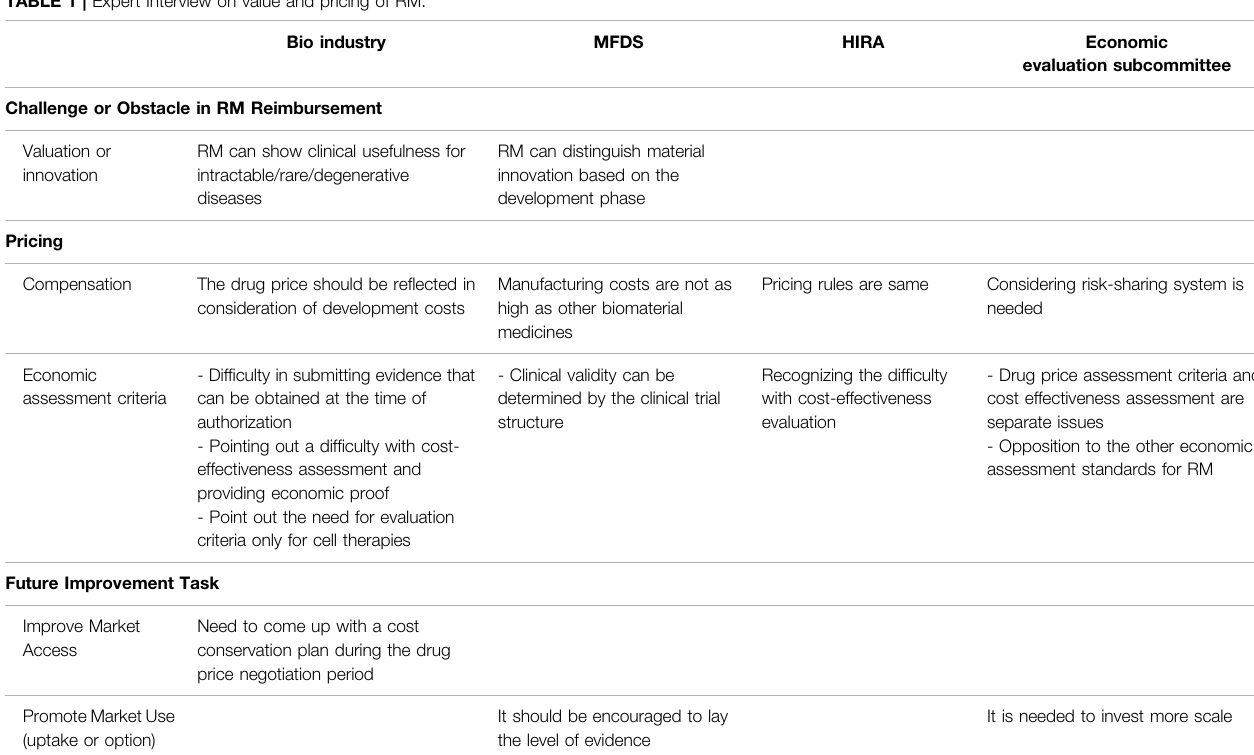
TABLE 1 | Expert Interview on value and pricing of